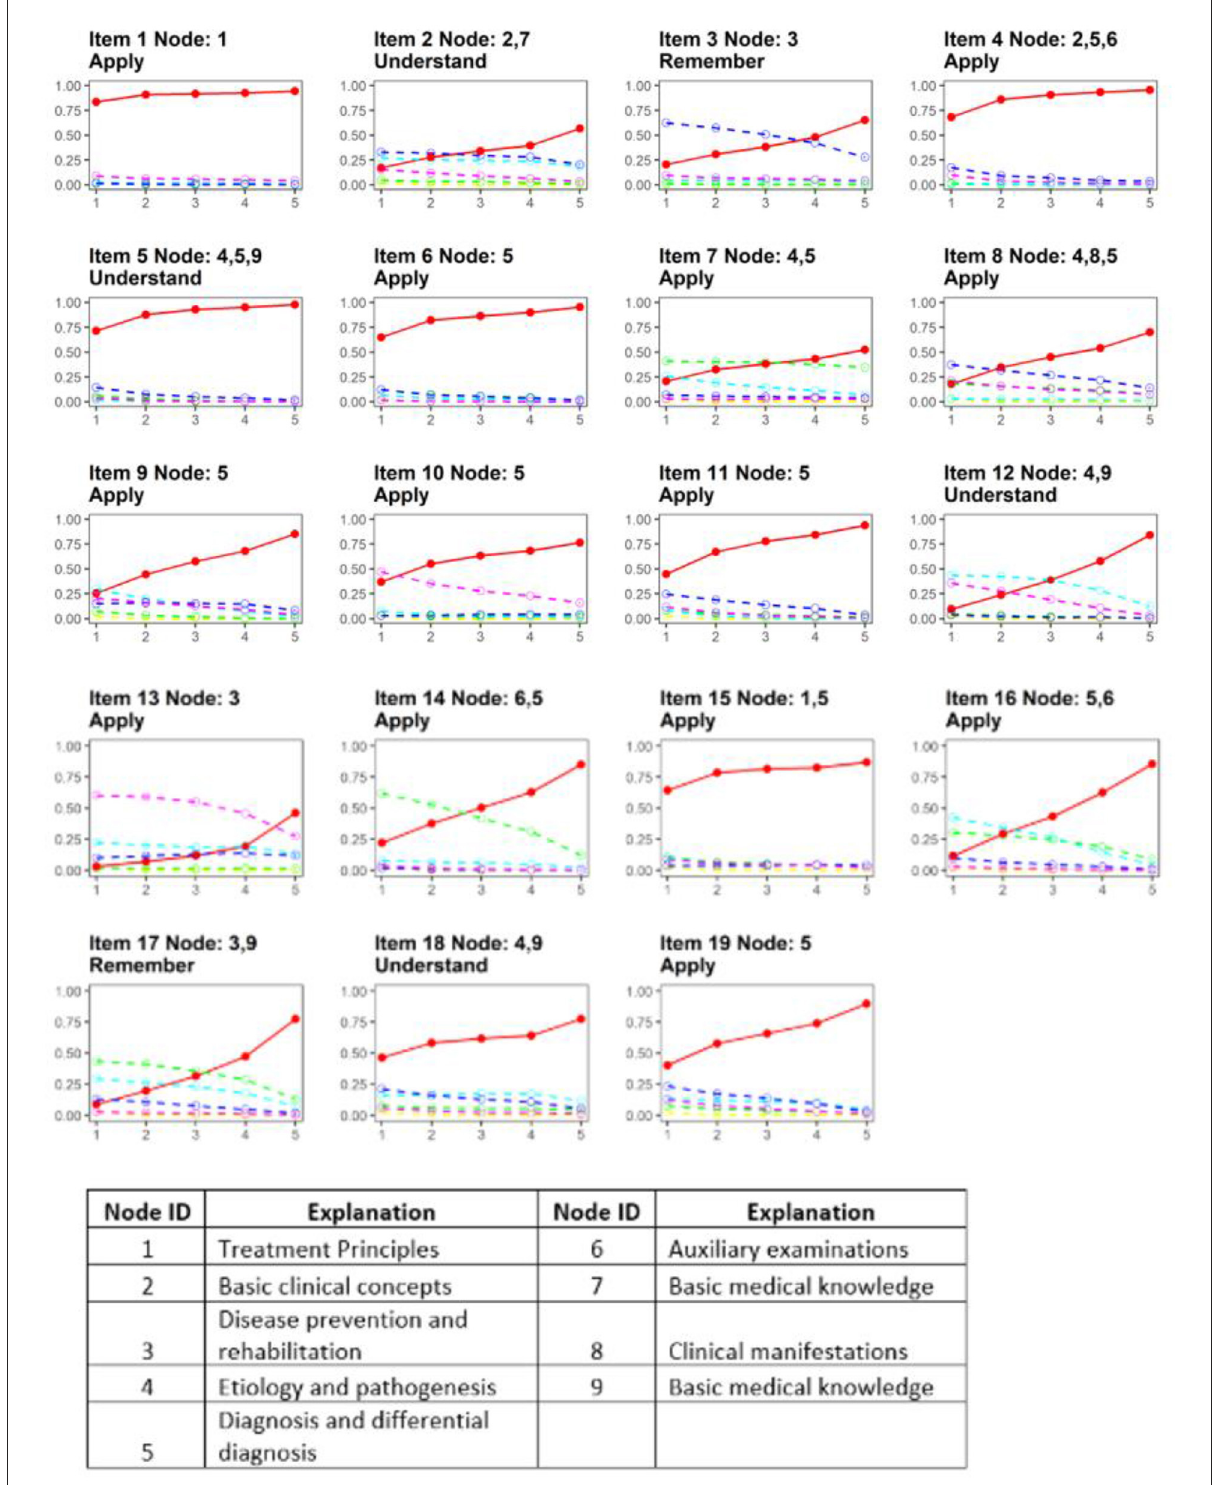
FIGURE2 Trace line plots of all items with assessed nodes and cognitive